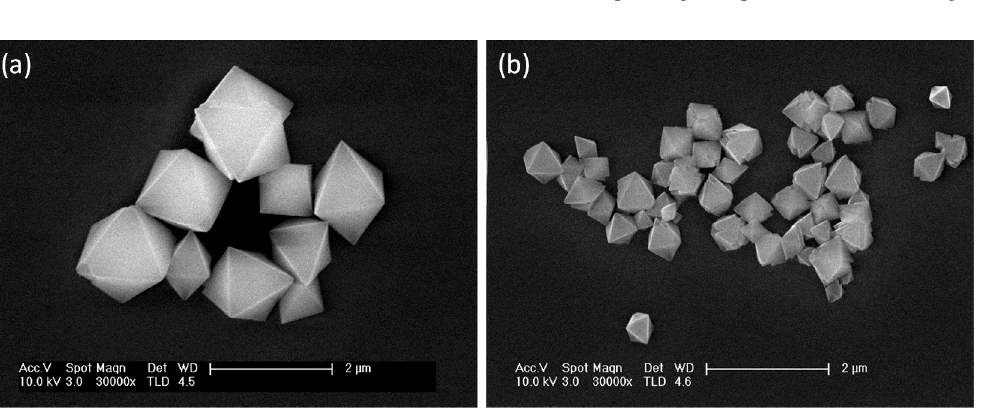
Figure 4. FESEM images of {[Cu 2 ( µ 3 -adeninato) 2 ( µ -Hadip) 2 ]} n : ( a ) octahedral 1.2 ± 0.3 micrometre particles obtained from experiment a ; and ( b ) octahedral 403 ± 130 nm particles obtained from experiment c .